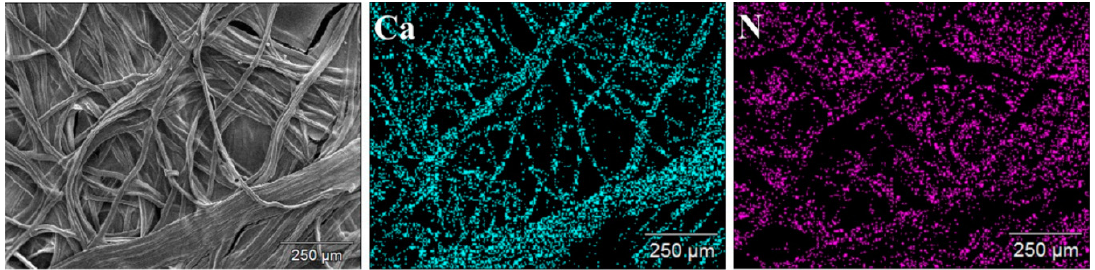
Figure 9. Energy-dispersive X-ray (EDX) mapping images of carboxymethyl chitosan and calcium alginate composite dressings [152]. (Reprinted with permission from Gao et al., 2019.)